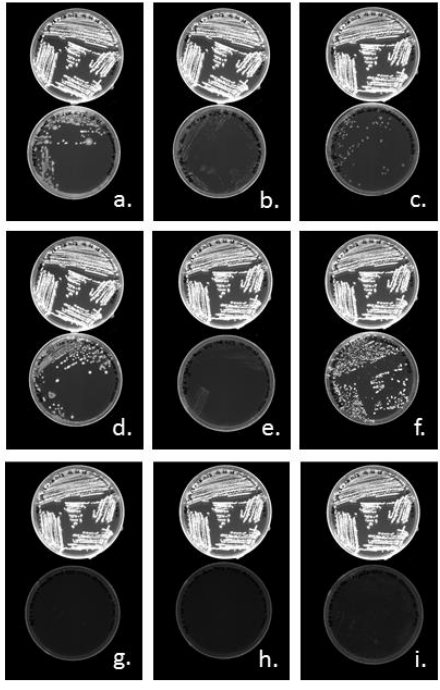
Figure 5. Nile Red agar plates screening with Halomonas sp. SF2003 using carbohydrates/acid mix with molar ratio 95/5%, final concentration 2% (w/v). Bacterial growth was evaluated under white light by the presence, or no, of colonies. PHA production was evaluated under UV-light by fluorescence emission from colonies, positive results appear as “white” colonies showing their fluorescence. Positive results appear as “white” colonies showing their fluorescence. The positive control (Glucose only) is the upper plate in ( a – i ). ( a ). Mix Glucose-Malic acid, ( b ). Mix Glucose-Levulinic acid, ( c ). Mix Glucose-Palmitic acid, ( d ). Mix Galactose-Malic acid, ( e ). Mix Galactose-Levulinic acid, ( f ). Mix Galactose-Palmitic acid, ( g ). Mix Fructose-Malic acid, ( h ). Mix Fructose-Levulinic acid and ( i ). Mix Fructose-Palmitic. Observations under UV-lights performed with transillumination.